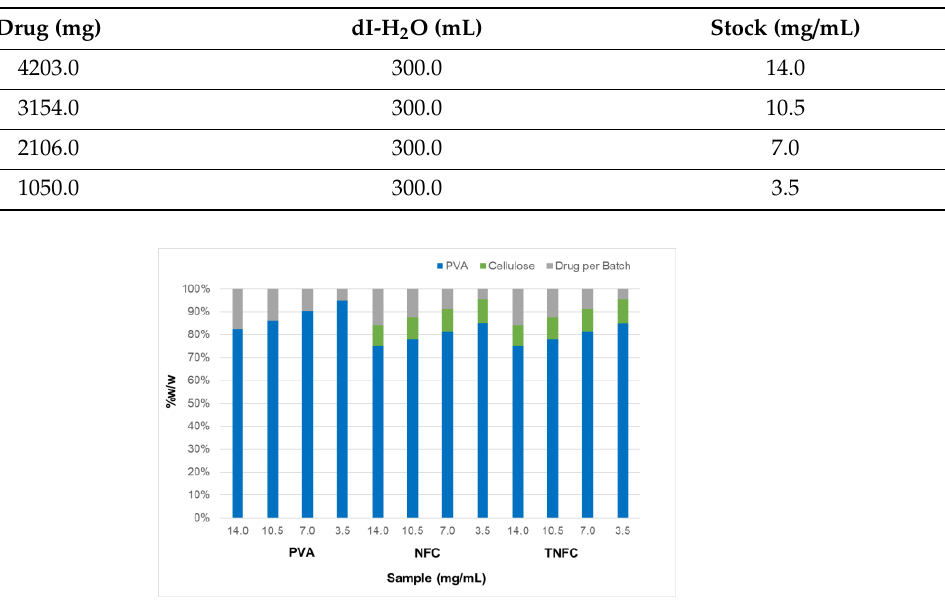
Figure 1. Formulations of poly (vinyl alcohol) (PVA), nanofibrillated cellulose (NFC)/PVA, and 2,2,6,6-Tetramethylpiperidine-N-oxyl (TEMPO)- oxidized NFC (TNFC)/PVA samples based on w / w